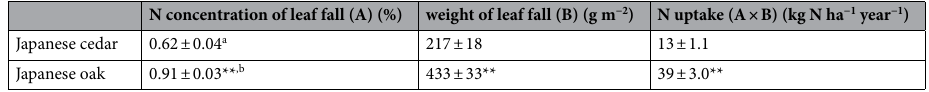
Table 3. Estimates of N uptake by Japanese cedar and Japanese oak plantations. a Mean ± standard deviation ( n = 5). b Significant difference ( p < 0.01 for t